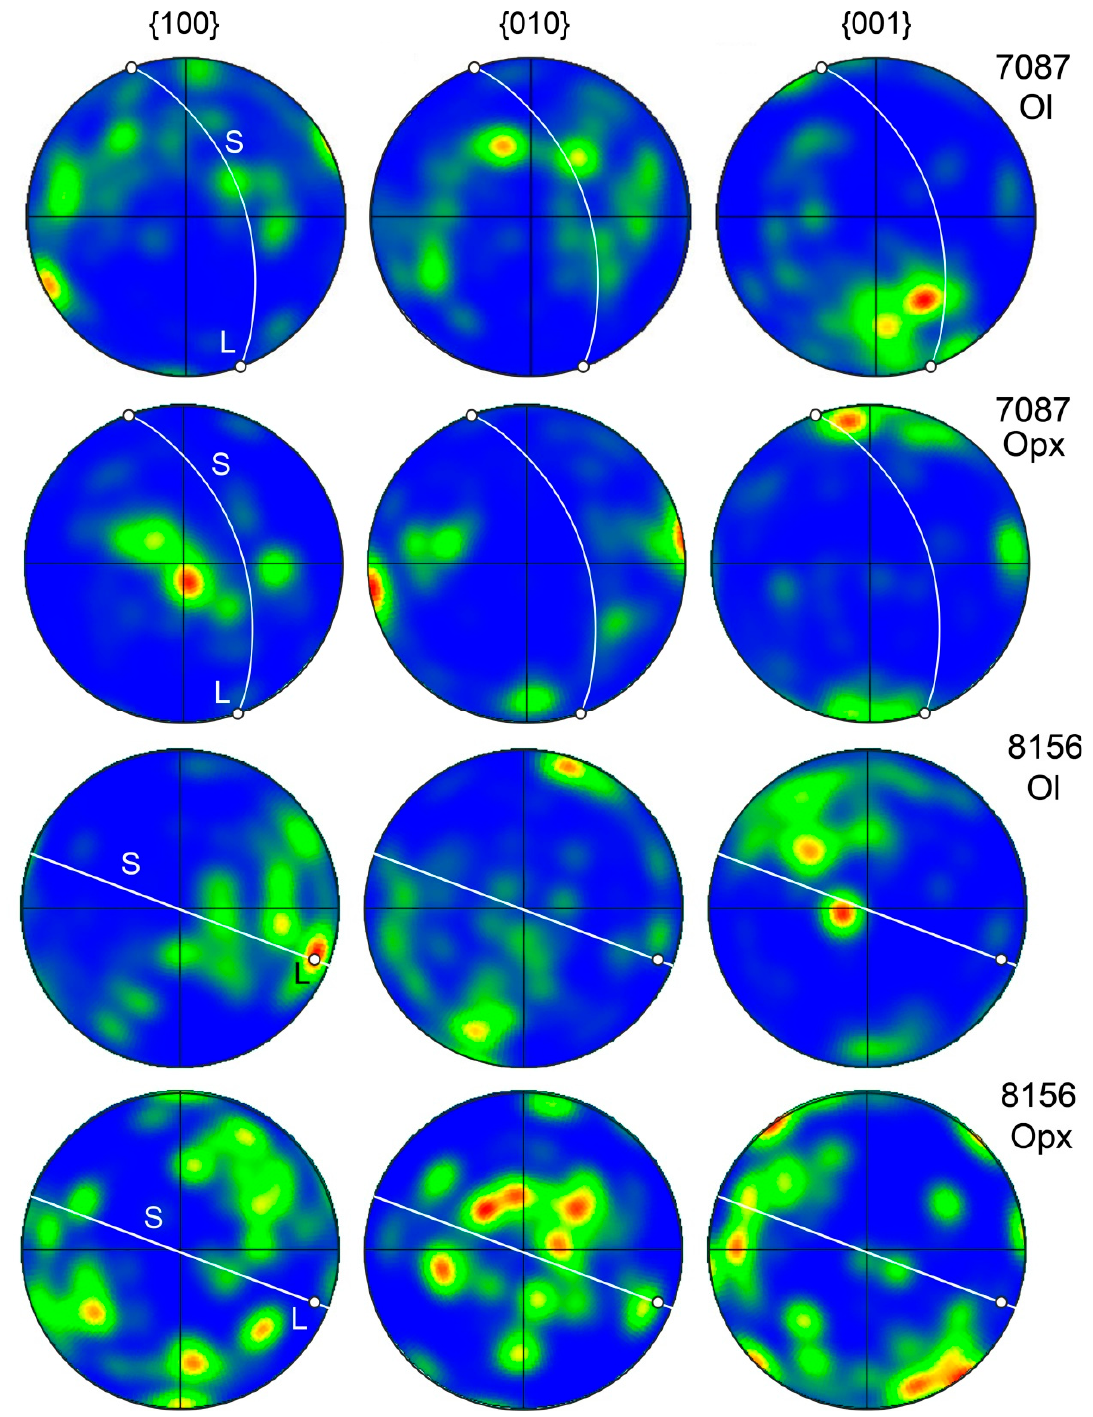
Figure 8. Olivine and orthopyroxene fabric in fresh lherzolites from well 766 of Kempirsay massif. Pole figures of the crystallographic orientation of olivine (Ol) and orthopyroxene (Opx) are presented in the upper hemisphere using an equal area projection. The color coding refers to the density of data points. S—foliation, L—lineation.